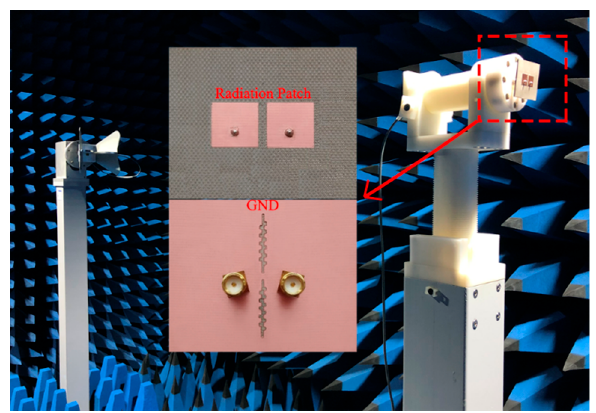
Figure 16. The photograph of fabricated sample of designed MIMO antenna together with microwave chamber and antenna measured environment, front and back sides of the antenna are zoomed in, in the photo center.